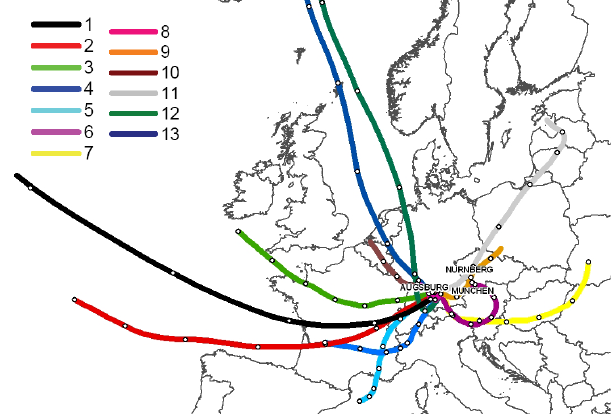
Fig. 13. Mean back trajectories of 13 trajectory clusters arriving at Augsburg. The duration of each trajectory is 6 days. One trajec- tory point corresponds to 24h. Trajectory No. 8, corresponding to stagnant air masses, is so short that it is not discernable in the figure.